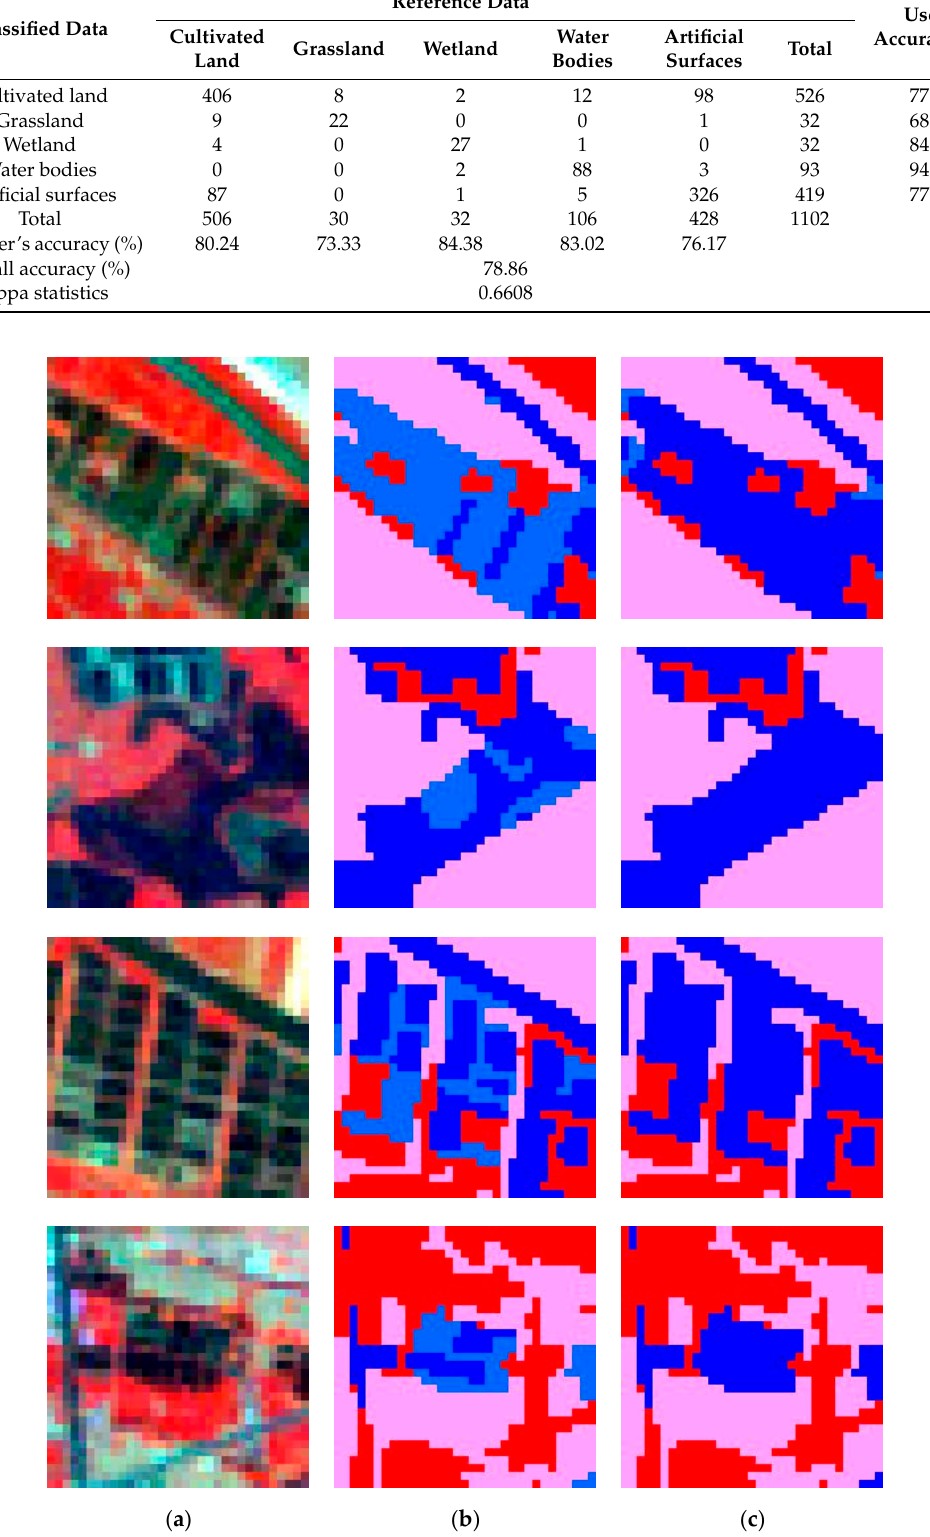
Figure 10. Comparative results for water bodies and wetlands: ( a ) remotely sensed image from the year 2011; ( b ) classification result without using brightness information; ( c ) classification result using brightness information. Table 5. Error matrix and classification accuracy for ECVA_OB+SVM.